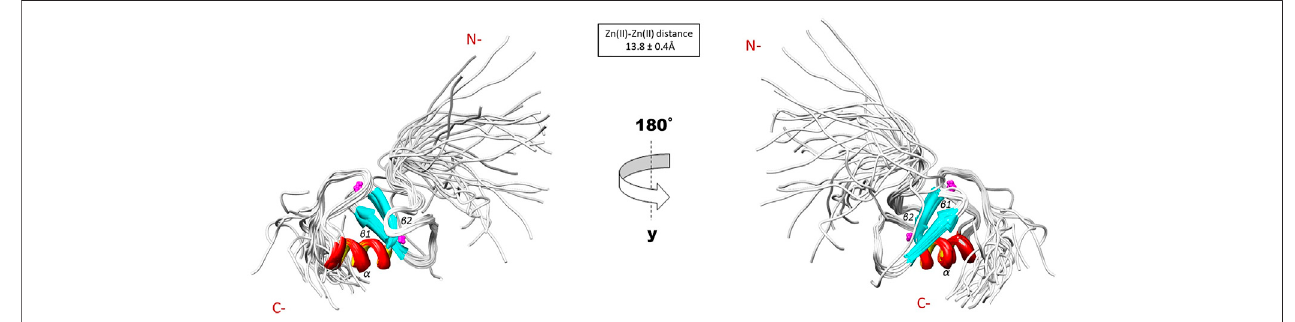
FIGURE 3 | Solution structure of the R957C RING domain as represented by the fi nal family of 30 energy minimized